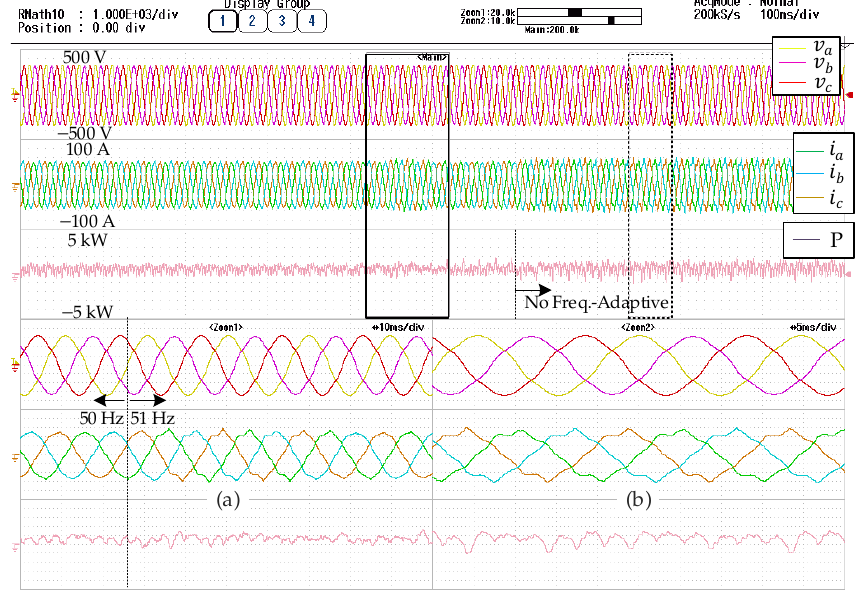
Figure 12. Experimental results delivering capacitive reactive power. Lowpass filter with a cutoff frequency of 1.5 kHz has been applied. ( a ) Zoom in voltage, current and three phase active power at the PCC when the grid frequency changed; ( b ) Zoom in voltage and current at the PCC without frequency-adaptive